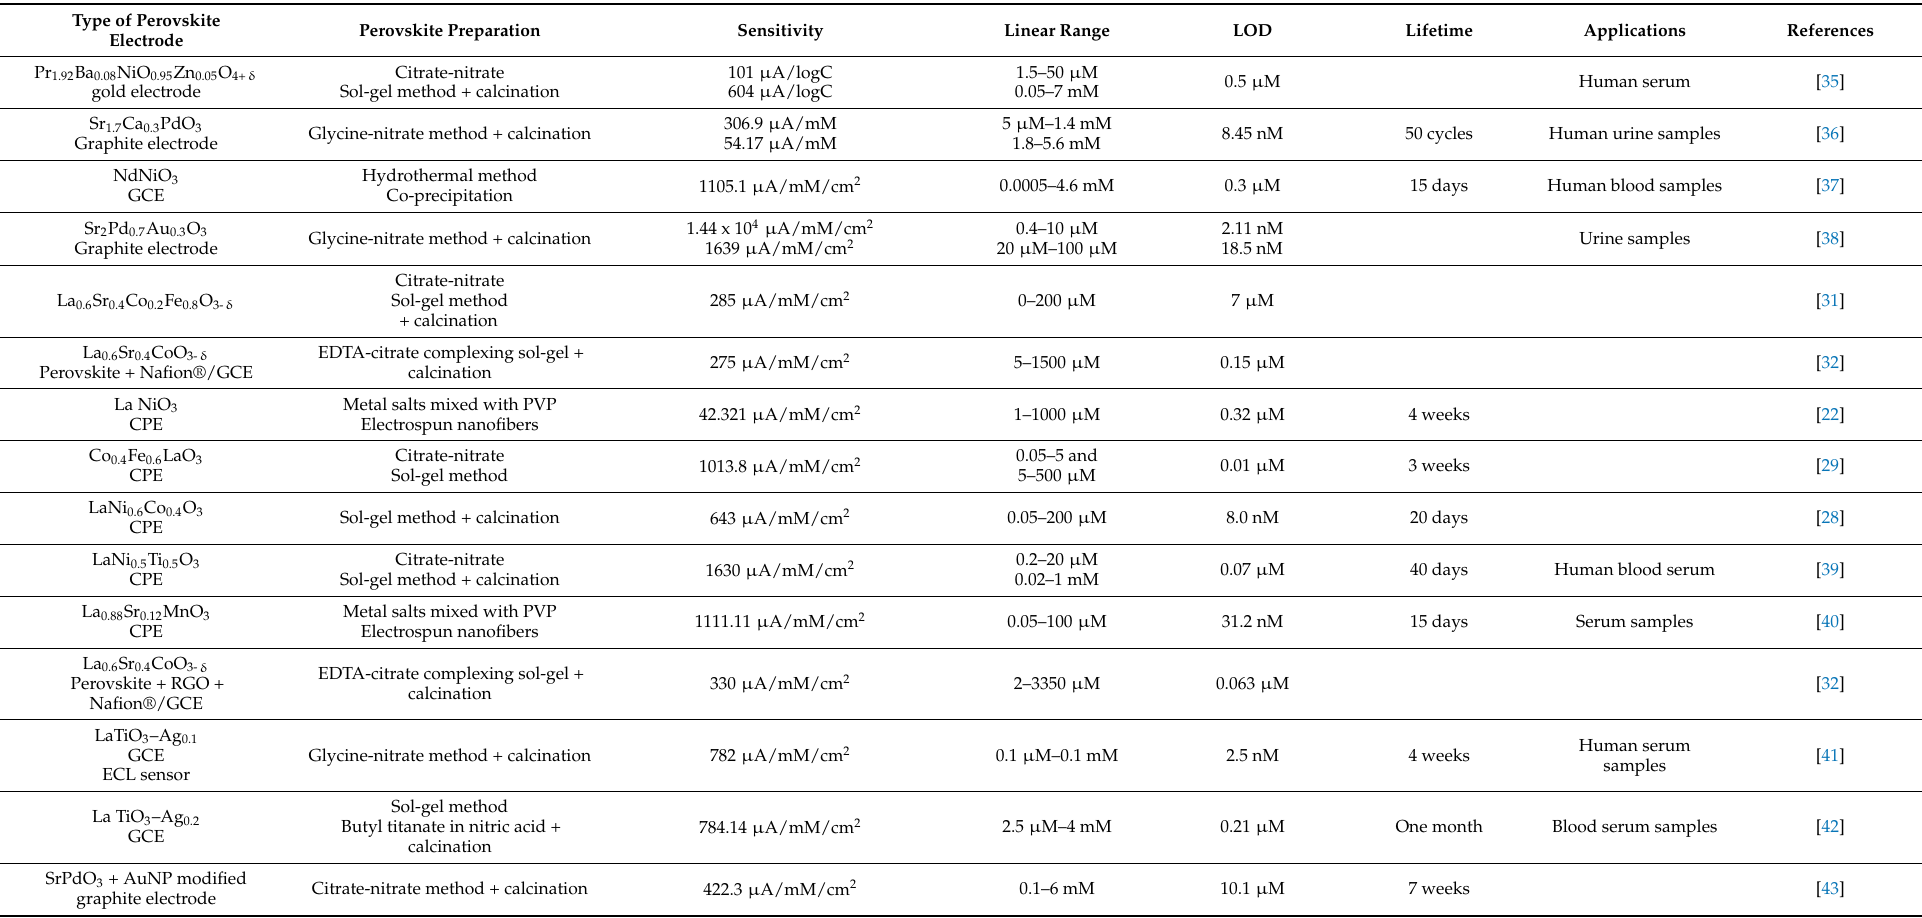
Table 2. Perovskite-based electrochemical sensors for the detection of